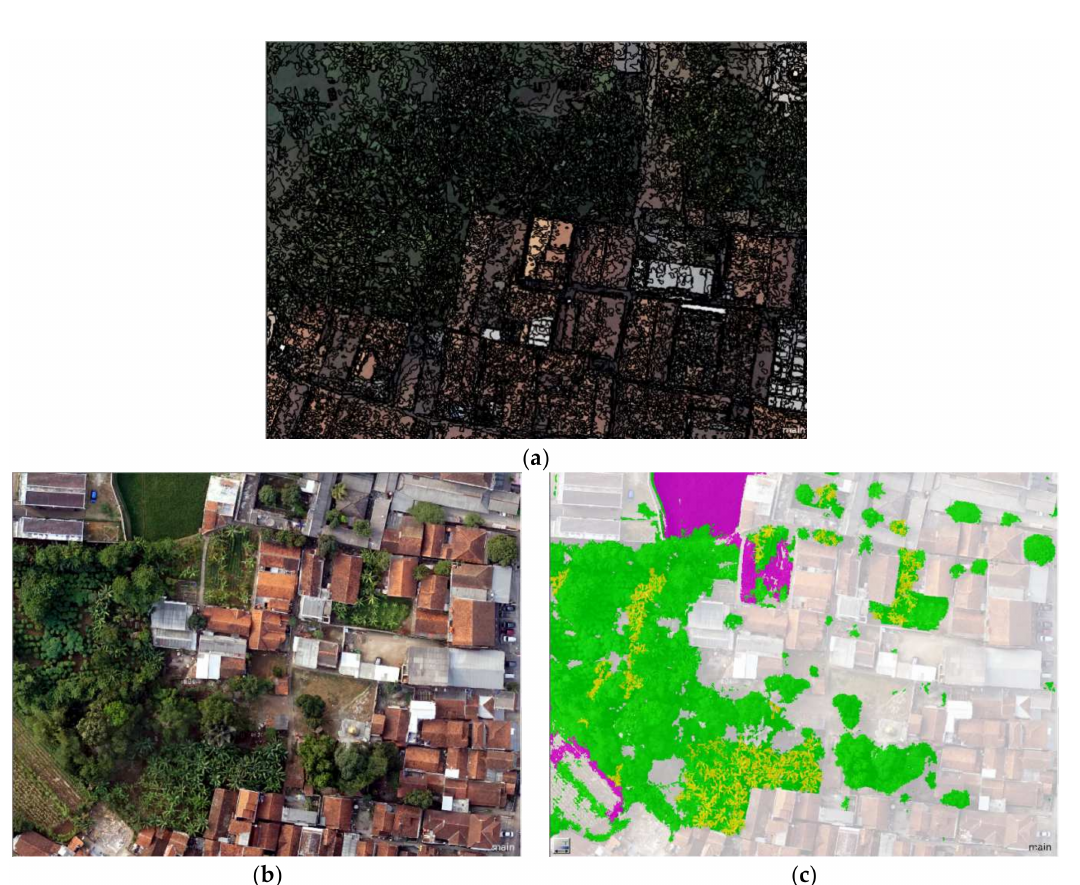
Figure 3. An implementation of OBIA to classify the distribution of banana herbs. Left to right: Aerial imagery before segmentation ( b ), after segmentation ( a ) and classification results of banana plants displayed in yellow ( c